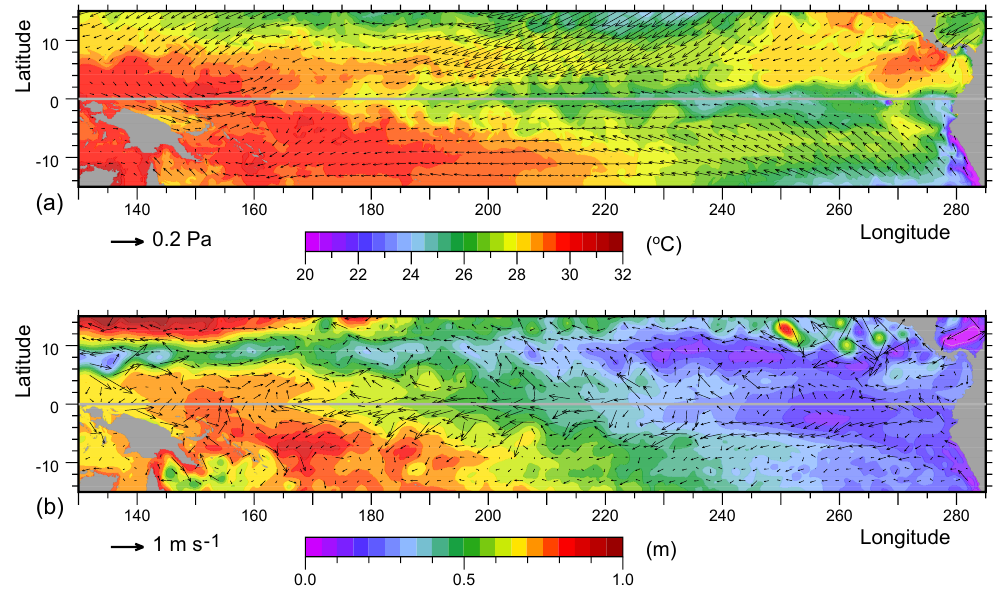
Figure 22. (a) Surface temperature and wind stress vectors. (b) Sea level (SSH) and velocity vectors are from the 29 March 1982 archive dataset. Each archive dataset contains averages over the previous 5 days of the model run.